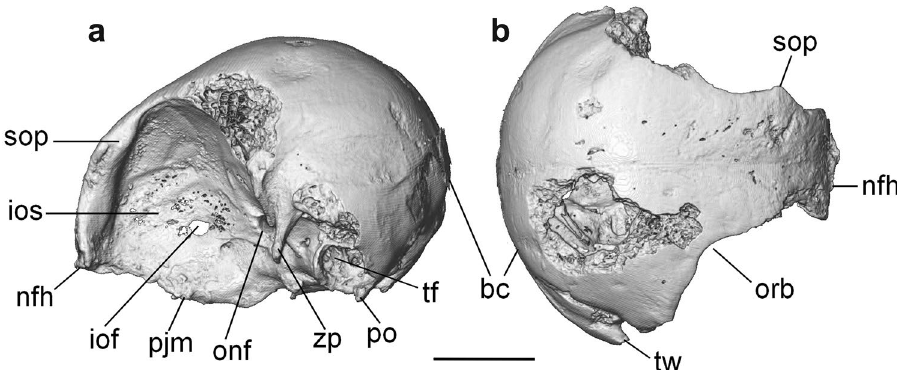
Figure 1. 3D reconstruction of O. murivorus cranium in lateral left ( a ) and dorsal ( b ) views. bc, braincase; iof, interorbital fenestra; ios, interorbital septum; nfh, naso-frontal hinge; onf, orbital nerve foramen; orb, orbit; pjm, palatines juction with mesethmoid; po, paroccipital process; sop, supraorbital process; tf, tympanic fossa; tw, tympanic wing; zp, zygomatic process. Scale bar, 10